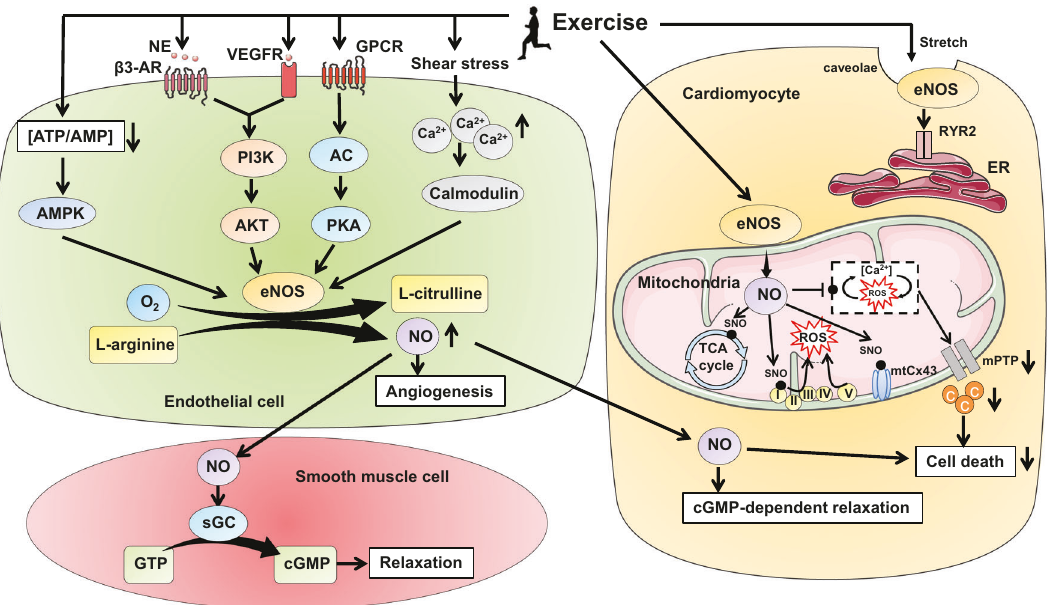
Fig. 5 The eNOS/NO signaling pathway in exercise-induced vascular adaptations and exercise-induced cardioprotection. Exercise can activate the eNOS/NO signaling pathway through either calcium-dependent or -independent ways. Exercise-induced shear stress leads to an increase of intracellular Ca 2 + within endothelial cells, which then interacts with calmodulin and activates eNOS and NO generation. Exercise can also activate the PI3K/AKT, AMPK, and PKA signaling pathways and subsequently increase eNOS phosphorylation and NO generation. The NO promotes angiogenesis or diffuses into adjacent vascular smooth muscle cells or cardiac muscle cells to induce cGMP-dependent relaxation. In cardiac muscle cells, exercise promotes the association of eNOS to the mitochondrial membrane, leading to increased NO bioavailability and S-nitrosylation of proteins involved in mitochondrial respiratory function, electron transport, and mPTP opening. The NO can further inhibit ROS and Ca 2 + interaction in the mitochondria and then protect cardiomyocytes from cell death. Meanwhile, the eNOS located in the caveolae within cardiac myocytes can also be activated by exercise-associated myocardial stress to facilitate the opening of sarcoplasmic reticulum RyR2. eNOS endothelial nitric oxide synthase, NO nitric oxide, NE norepinephrine, β 3-AR β 3-adrenoceptor, VEGFR vascular endothelial growth factor receptor, PI3K phosphoinositide-3 kinase, AKT protein kinase B, AMPK adenosine monophosphate-activated protein kinase, GPCR G protein-coupled receptor, AC adenylate cyclase, PKA protein kinase A, sGC soluble guanylyl cyclase, cGMP cyclic guanosine monophosphate, SNO N-nitrosylation, ROS reactive oxygen species, mPTP mitochondrial permeability transition pore, c cytochrome c, ER endoplasmic reticulum, RyR2 reticulum ryanodine receptor type